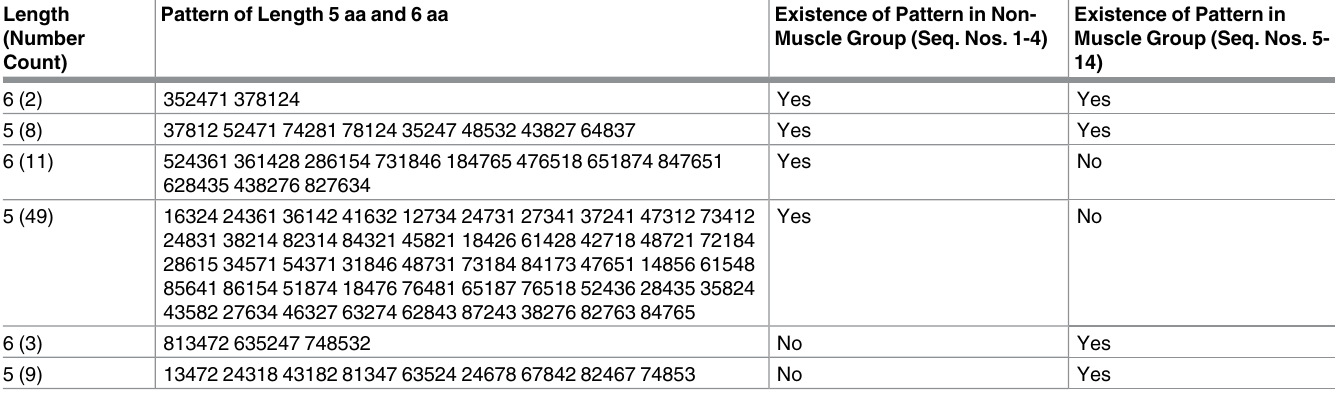
Given an input of pattern length (L), all possible combination of pattern of length L using the numerical number 1-8 are generated without repetition using Algorithm